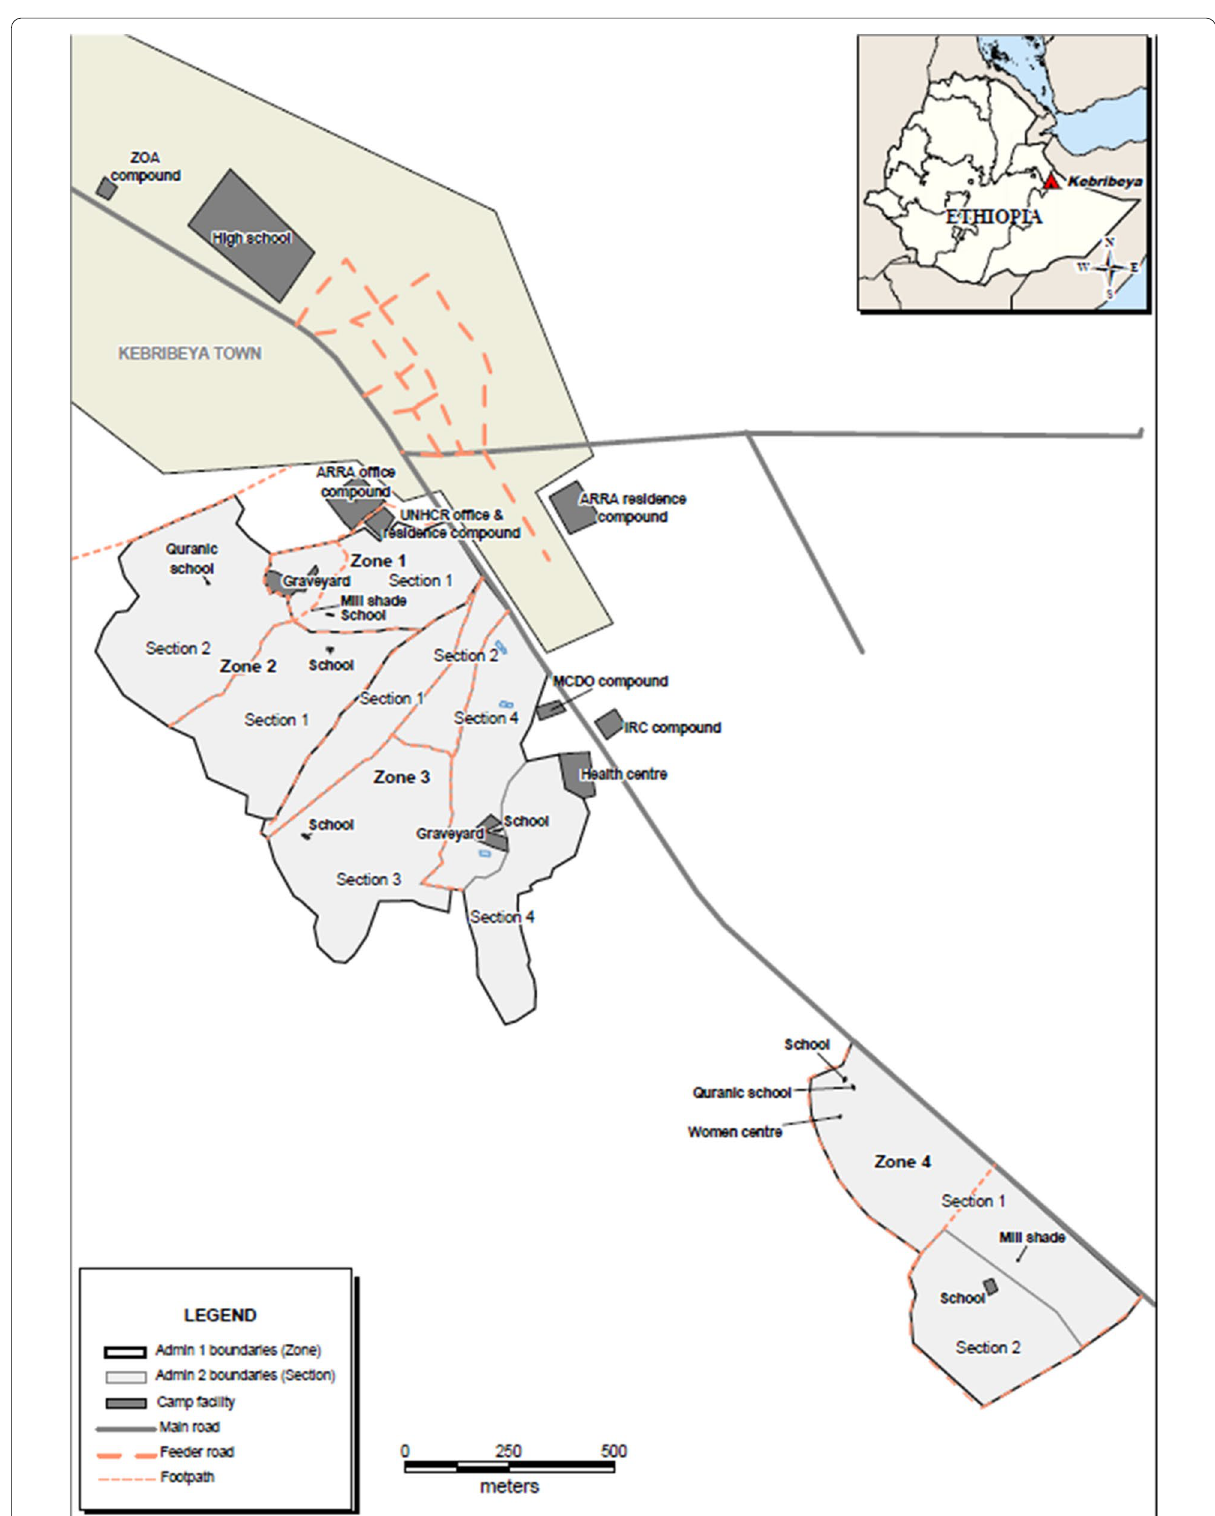
Fig. 2 Kebribeyah Camp (UNHCR, 2012, b) (The boundaries and names shown and the designations used on this map do not imply official endorsement or acceptance by the United